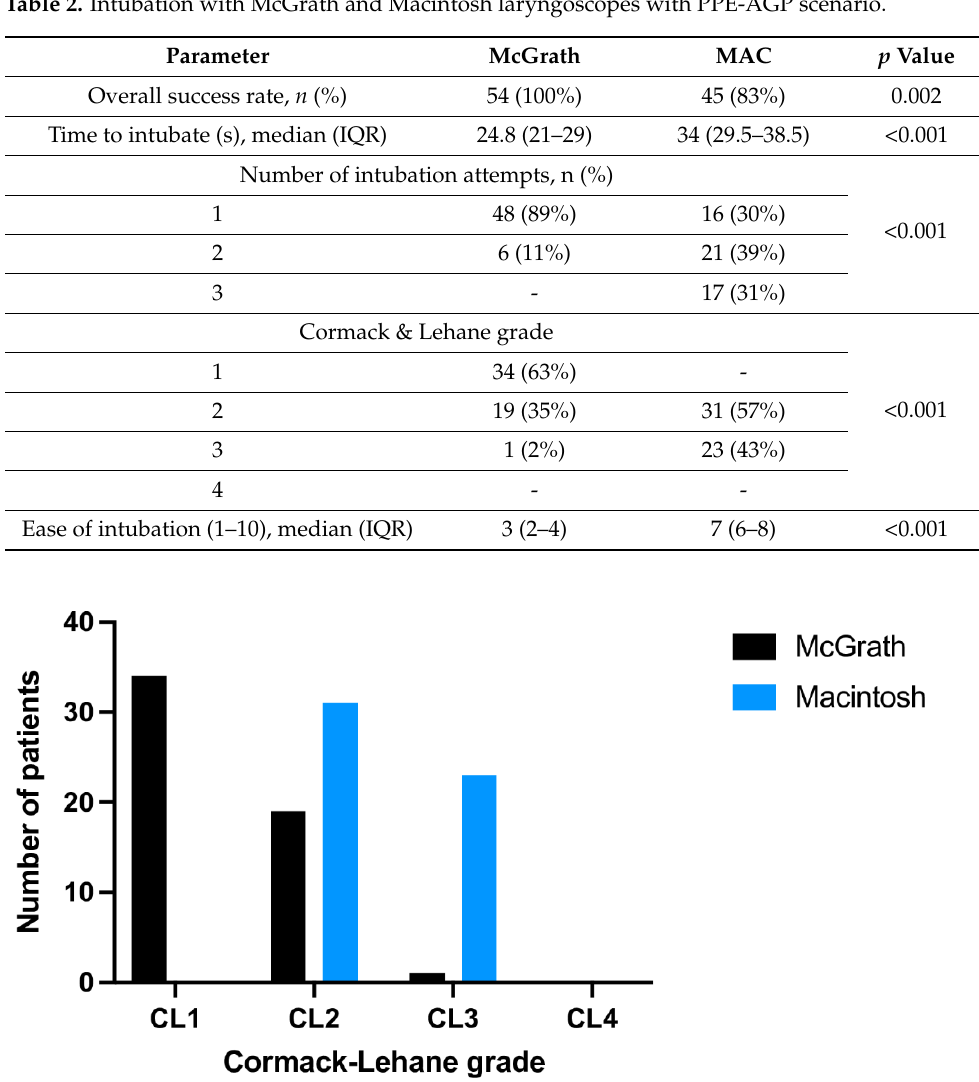
Figure 4. Cormack-Lehane grades in a scenario with either the McGrath or the Macintosh laryngoscope in a scenario with PPE-AGP.